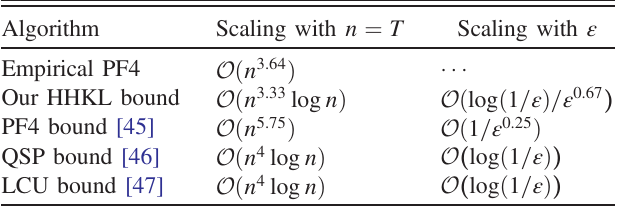
TABLE I. A comparison between the gate complexity of several quantum simulation algorithms for simulating one-dimensional power-law systems at T ¼ n and α ¼ 4 . Our analysis shows that the HHKL algorithm performs at least as well as the empirical gate count of PF4, while having a similar poly ð 1 = ε Þ scaling with the error ε . It is not known whether the empirical gate count of PF4 can scale with ε better than suggested by the best proven bound (third